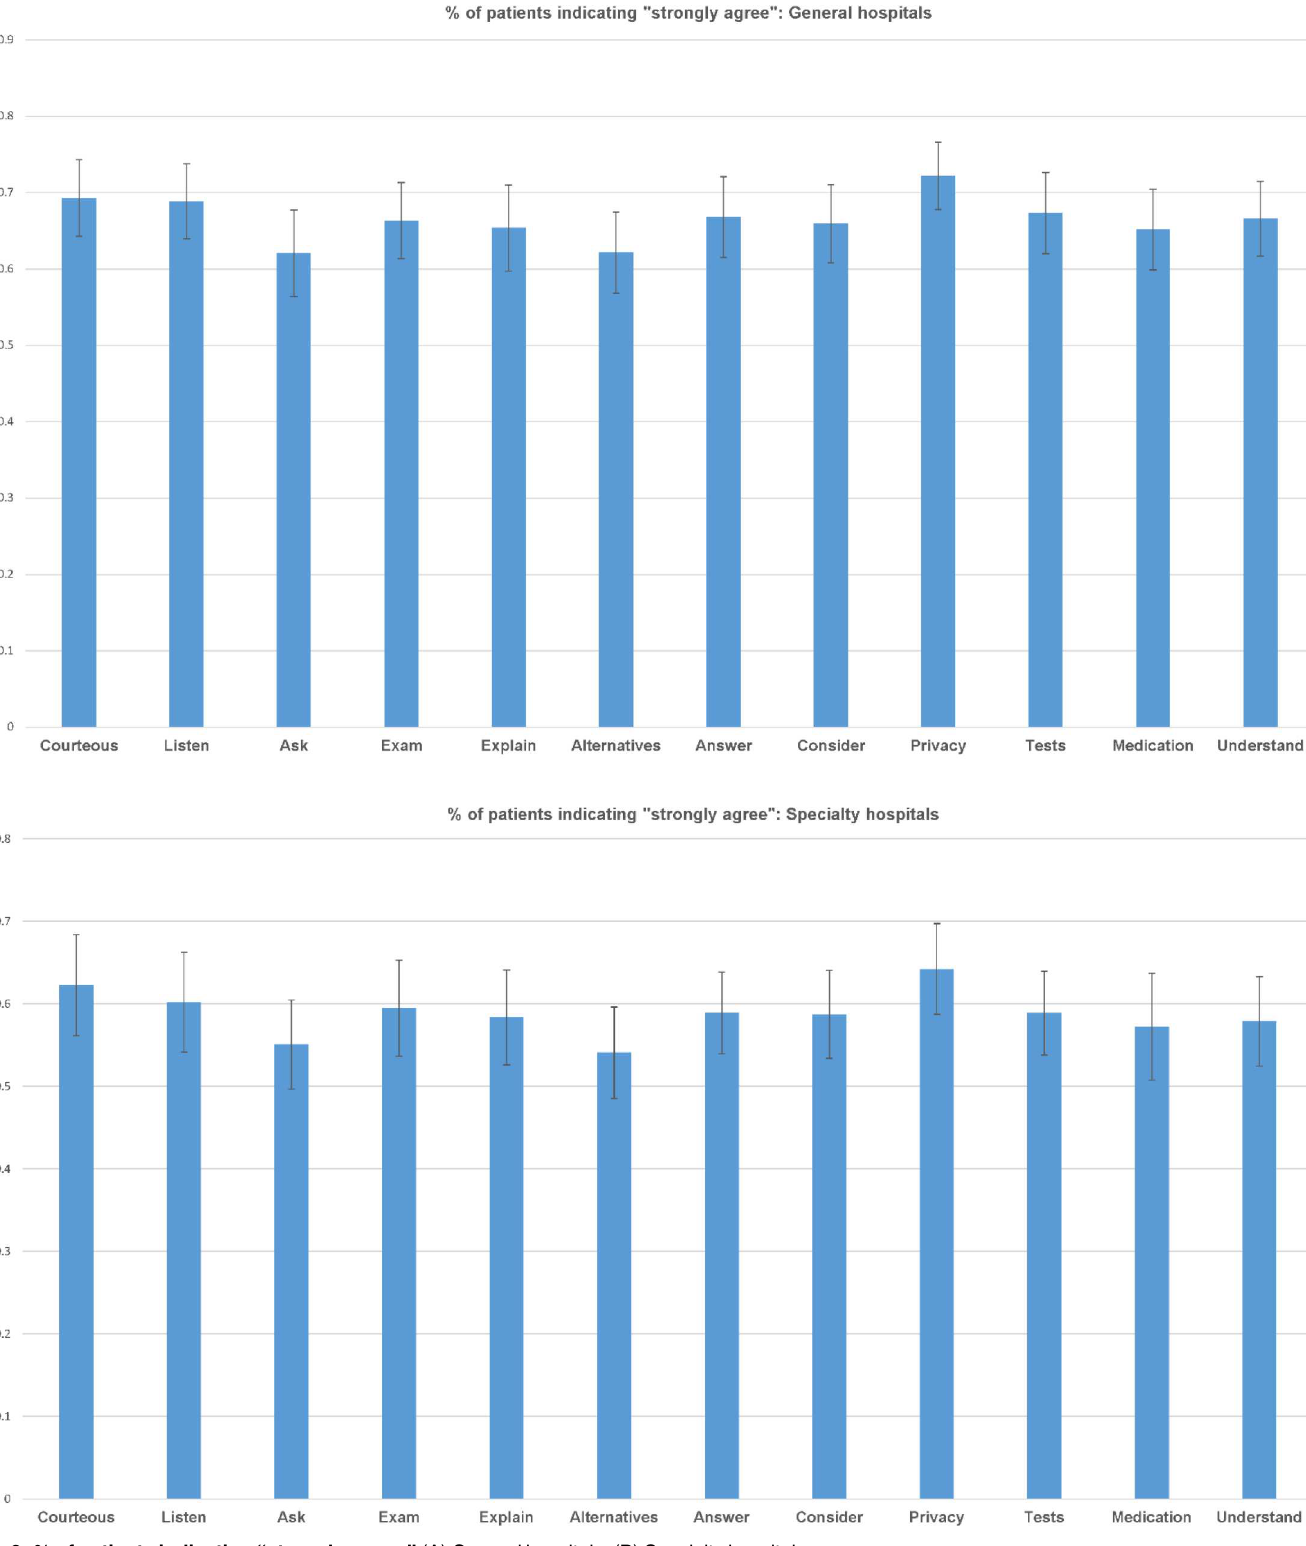
Fig 2. % of patients indicating “strongly agree.” (A) Generalhospitals.(B) Specialty hospitals.